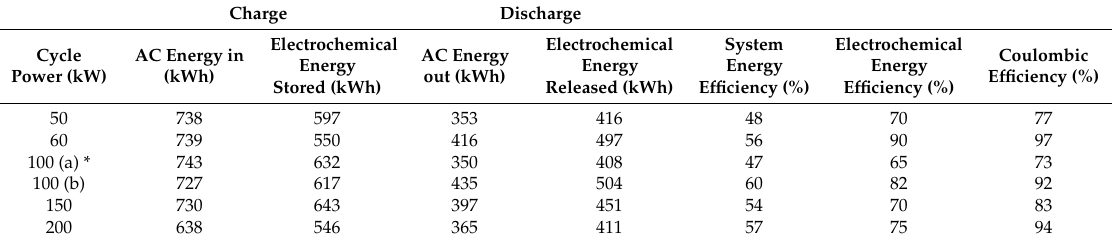
Table 4. The coulombic efficiency, evaluated from system and battery energy efficiencies, at the various power